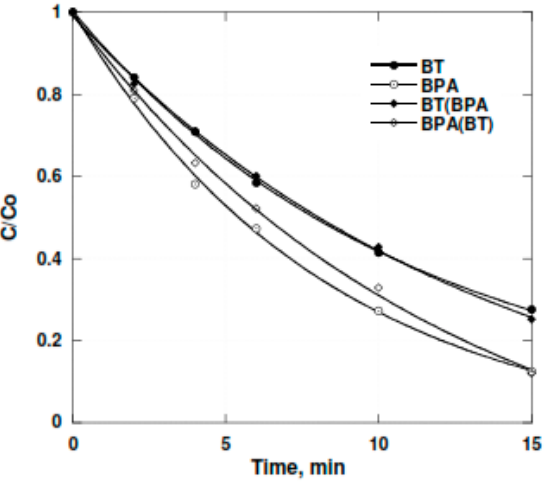
Figure 9. The degradation rate at 352 kHz of a mixture bisphenol A (BPA) (BT-7.0 × 10 − 6 M) in deionized water. Temperature 21°C ± 1°C; Electrical input 80 W.